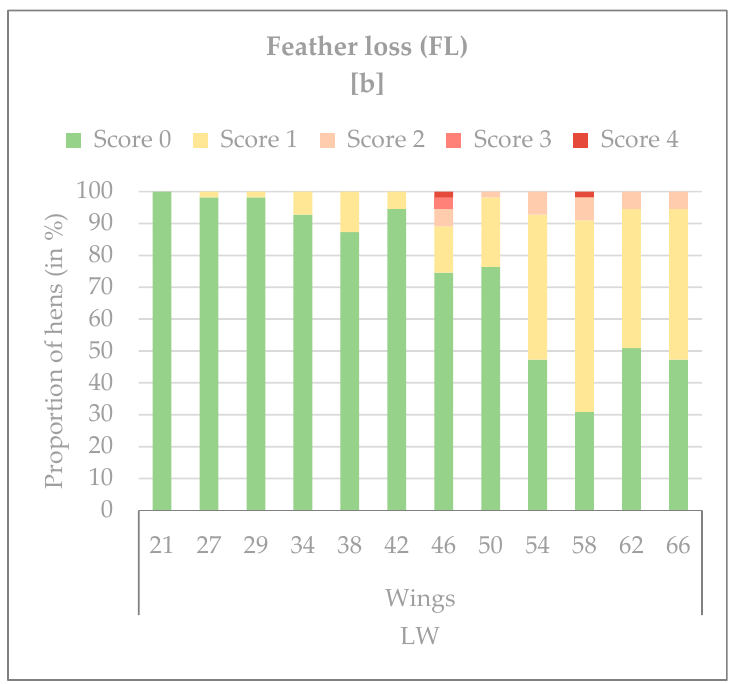
Figure 8. ( a ) and ( b ) Proportion (in %) of hens ( n = 50 (week 21); n = 55 (weeks 27–66)) with di ff erent Figure 8. ( a and b ) Proportion (in %) of hens ( n = 50 ( week 21); n = 55 (weeks 27–66)) with different scores (0–4) for FL at di ff erent LW for di ff erent body sections (a: back and tail; b: scores (0–4) for FL at different LW for different body sections (a: back and tail; b: wings).